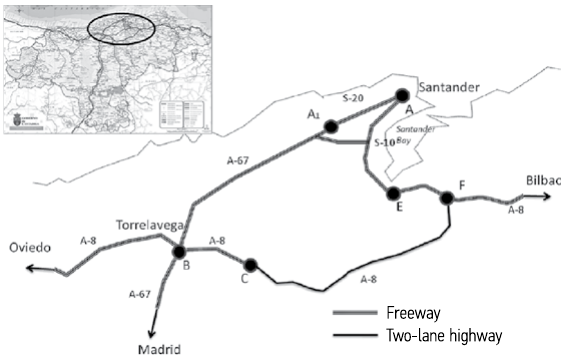
Fig. 4. Existing road network in the study area